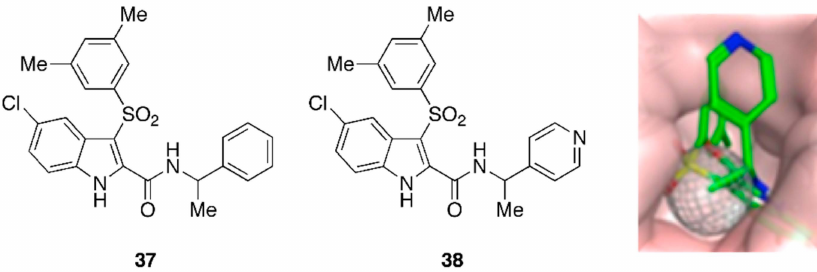
RT: the surface shows shape and position of the methyl group following the induced fit